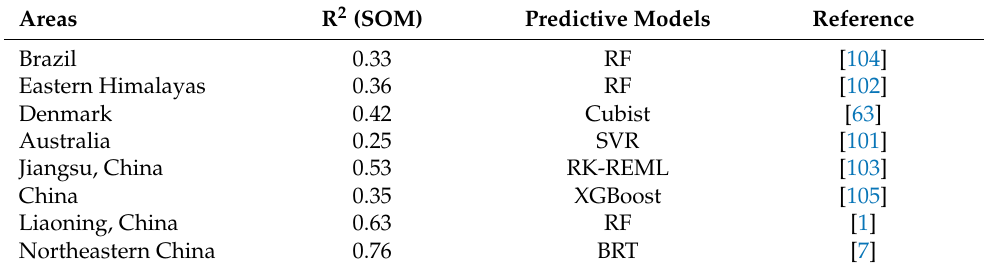
Table 6. Comparison of the results of this study with published achievements. Areas R 2 (SOM) Predictive Models Reference Brazil 0.33 RF [104] Eastern Himalayas 0.36 RF [102] Denmark 0.42 Cubist [63] Australia 0.25 SVR [101] Jiangsu, China 0.53 RK-REML [103] China 0.35 XGBoost 0.63 Northeastern China 0.76